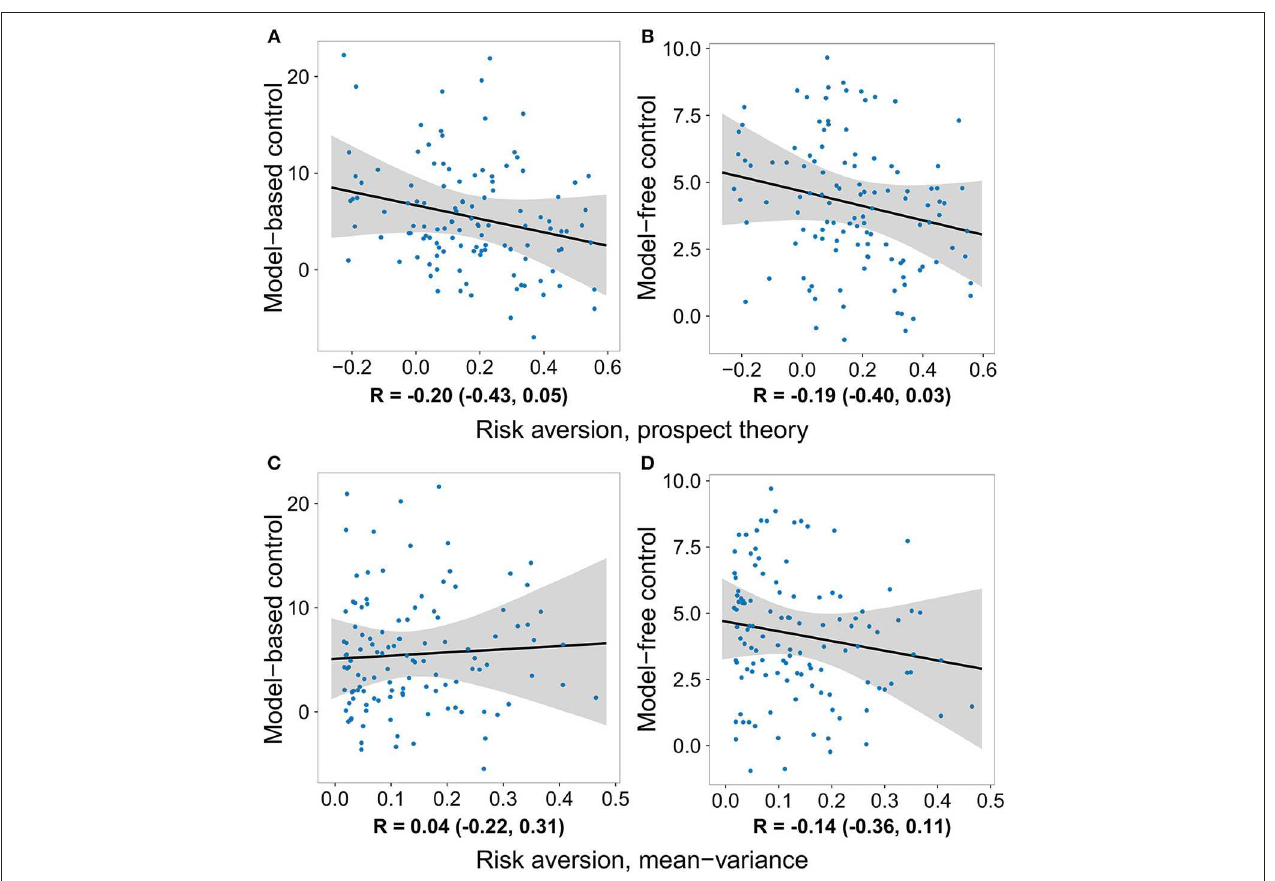
FIGURE 3 | The degree to which individuals deploy each decision system plotted against their degree of risk aversion, after removing the effects of loss aversion and the gambling task inverse softmax temperature. No significant relationship was observed between risk preference and either decision system. (A) Model-based control vs. risk aversion measured using the prospect theory model. (B) Model-free control vs. risk aversion measured using the prospect theory model. (C) Model-based control vs. risk aversion measured using the mean-variance model. (D) Model-free control vs. risk aversion measured using the mean-variance